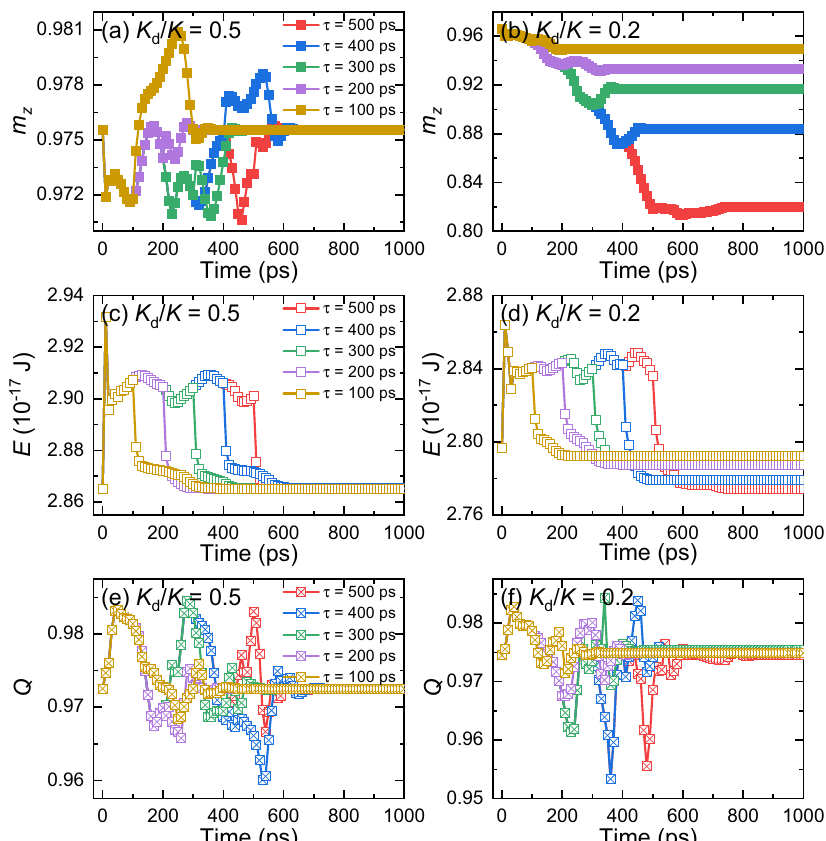
Fig. 5 Out-of-plane magnetization, energy, and topological charge of the system driven by current pulses with different pulse lengths. a Time- dependent out-of-plane magnetization m z corresponding to the current-induced hopping motion of a square-shaped skyrmion in a sample with K d / K = 0.5 for different pulse lengths τ . K and K d stand for the perpendicular magnetic anisotropy constants for the unmodi fi ed areas and defect lines, respectively. A current pulse of j = 100 MA cm − 2 and p ¼ (cid:2) ^ y is applied, and then the system is relaxed until t = 1000 ps. b Time-dependent out-of-plane magnetization m z corresponding to the current-induced deformation of a square-shaped skyrmion in a sample with energy E of the system corresponding to ( a ). ( d ) Time-dependent E corresponding to ( b ). e Time-dependent numerical topological charge Q of the system corresponding to ( a ). f Time-dependent numerical Q corresponding to ( b